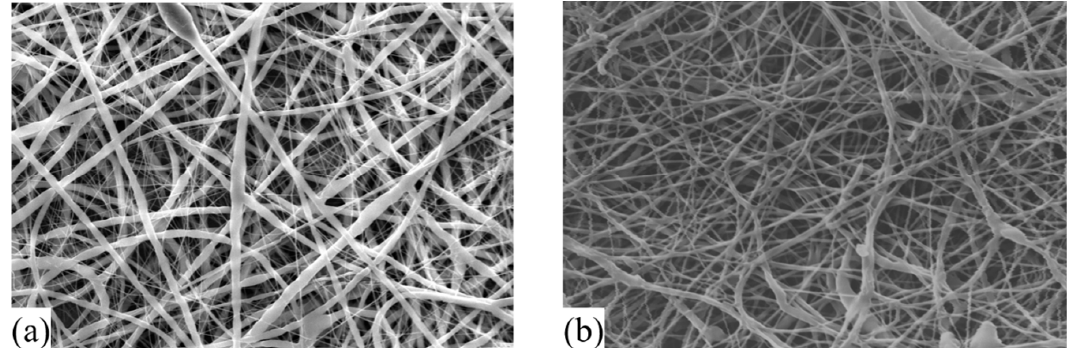
Figure 3. SEM images for the ( a ) poly( ε -caprolactone) (PCL) and ( b ) PCL + PEGSP2 30 % wt nanofibers.